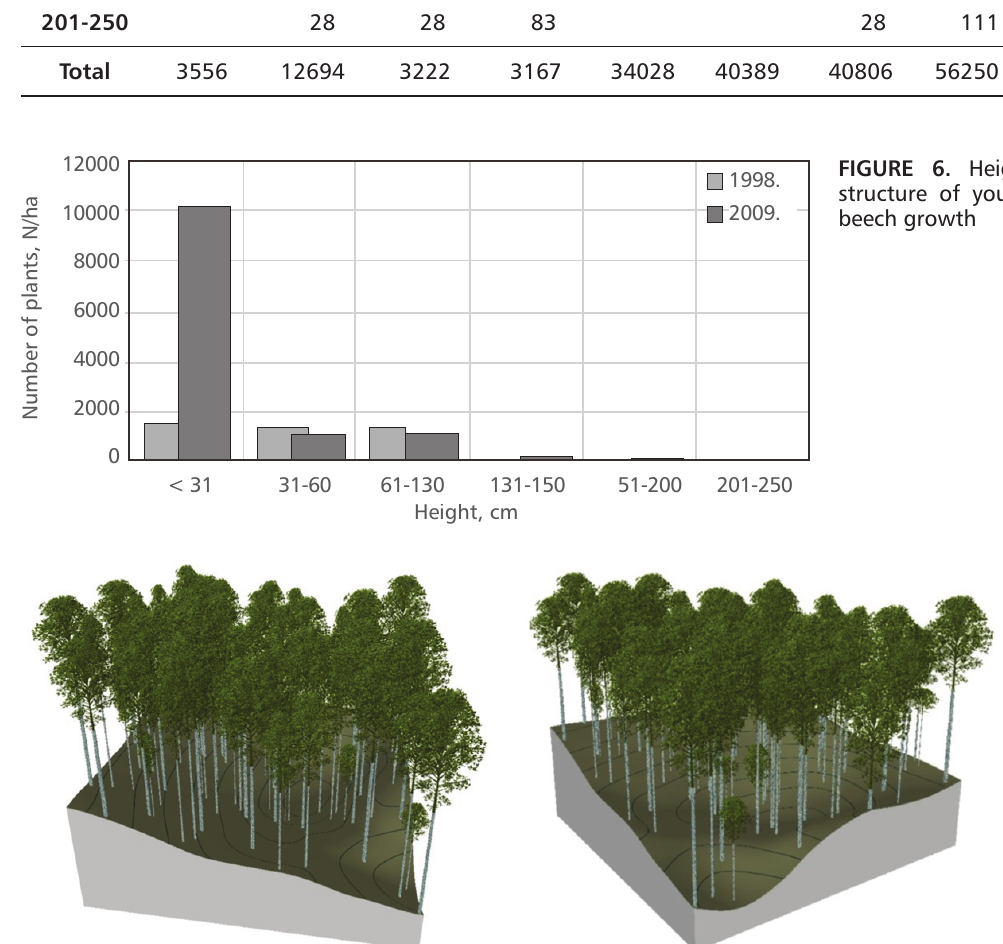
SEEFOR 4 (2): 95-103 101 © CFRI http://www.seefor.eu